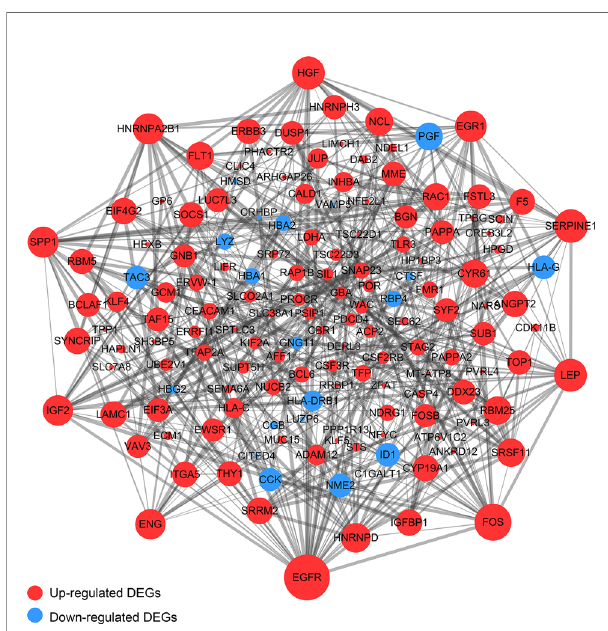
FIGURE 7 | The PPI Network of DEGs. The upregulated genes were exhibited by the red color, while the blue color exhibited the downregulated genes. Node size is proportional to the degree of the node itself. Edge width is proportional to the combined degree between